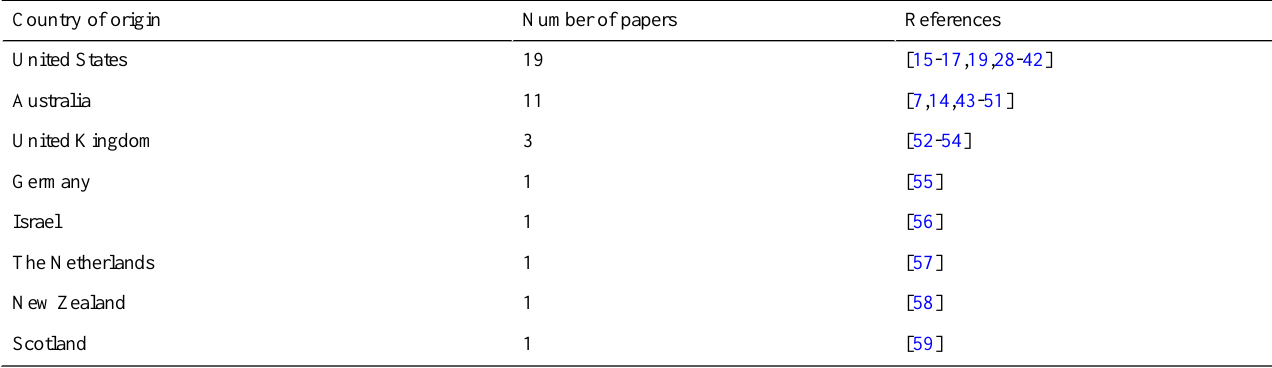
Table 1. Yield of papers by country of